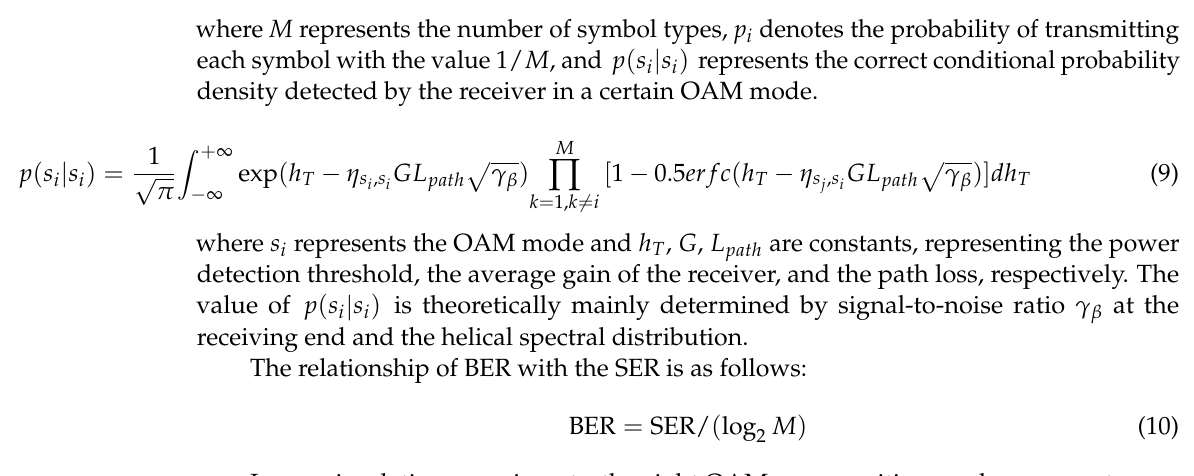
Figure 6. Plane wave interferogram of single-mode vortex beam with large topological